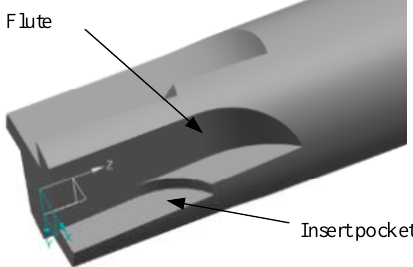
Figure 2. Flute and insert pocket of the staggered PCD end mill.